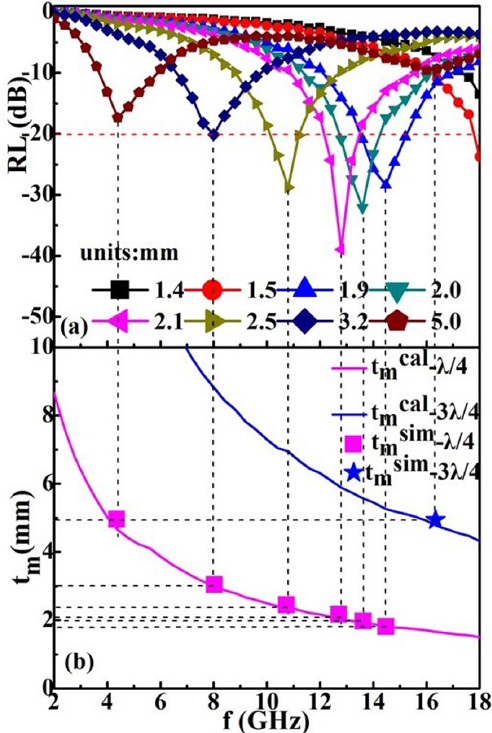
Figure 5. (a) Dependence of RL on frequency at various thicknesses for the Ni-paraffin composites; and (b) Dependence of λ/4 and 3λ/4 thickness on frequency for the Ni-paraffin composites.